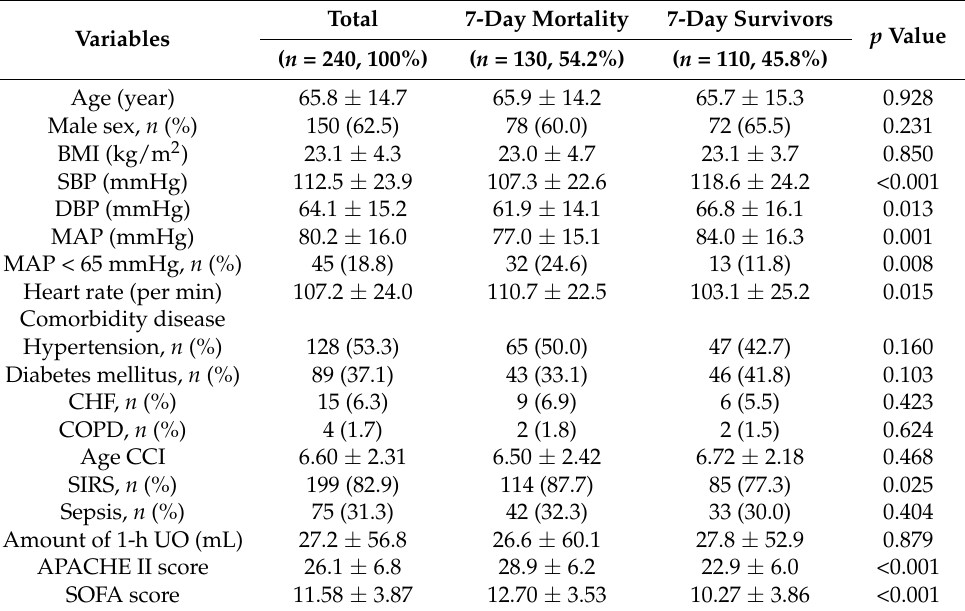
Table 1. Baseline characteristics of study